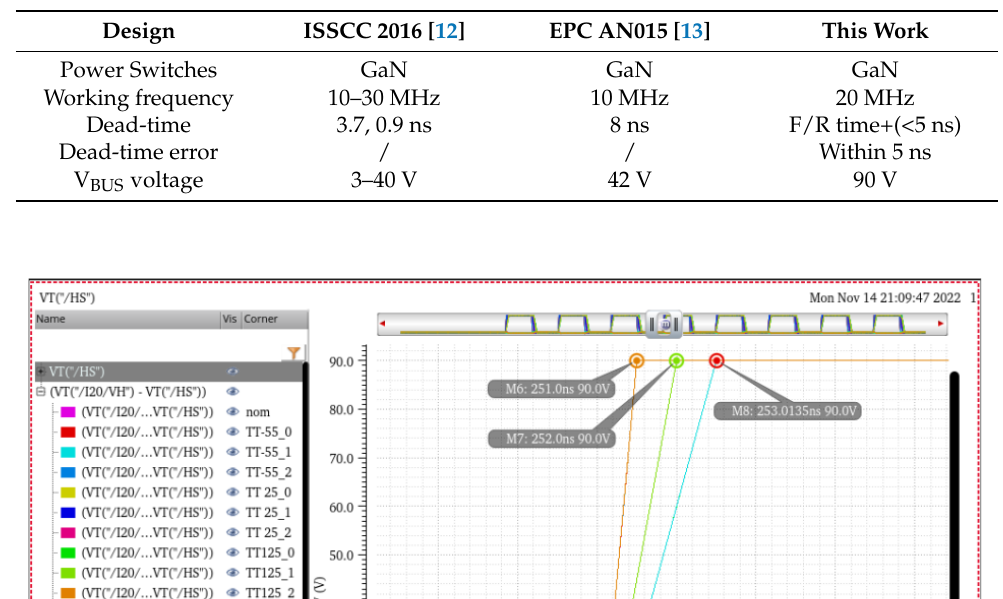
Table 1. Performance comparison.